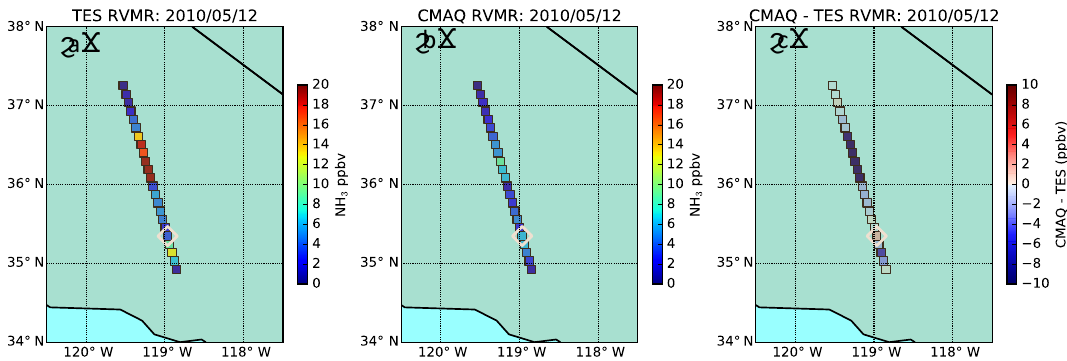
Figure 7. NH 3 representative volume mixing ratios (RVMRs) on 12 May 2010 during the CALNEX campaign for (a) TES special obser- vations, (b) modeled RVMR for CMAQ and (c) the difference between each RVMR near the Bakersfield, CA, surface site, with the white diamond locating the Bakersfield measurement site.